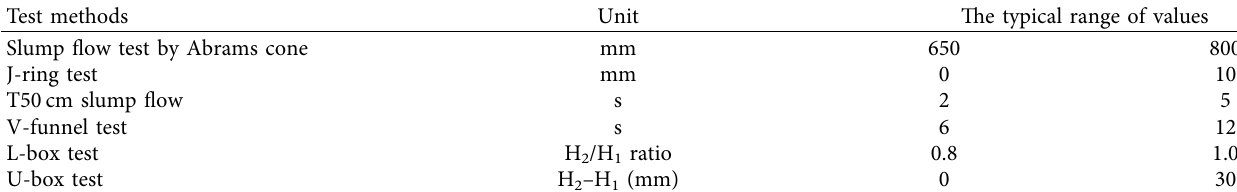
Table 5: SCC fresh properties tests: satisfactory Limits as per EFNARC 2005 guidelines.